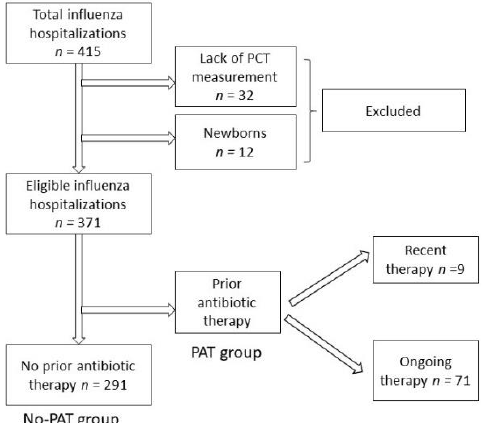
Figure 1. A flow chart of the patients included in the study. Abbreviations: PCT—procalcitonin, PAT group—prior antibiotic therapy, No-PAT—no prior antibiotic therapy. Influenza type A was diagnosed in 268 (72.2%) cases, type B in 90 (24.3%), while type A and B coinfection occurred in 13 (3.5%) cases.